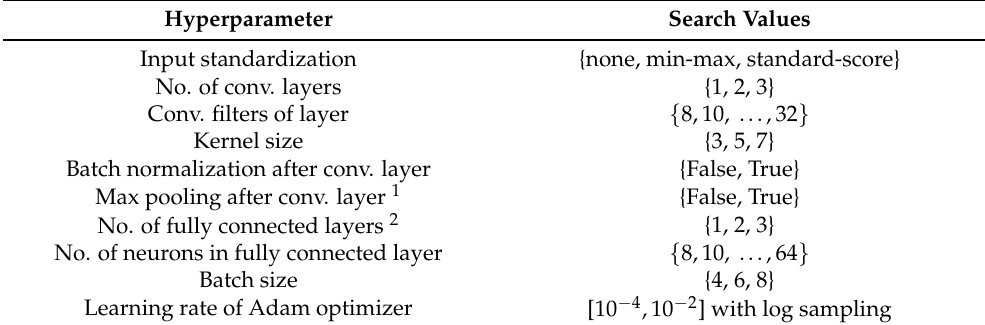
Table 1. The hyperparameters of the CNN model optimized via the Hyperband algorithm. Hyperparameter Search